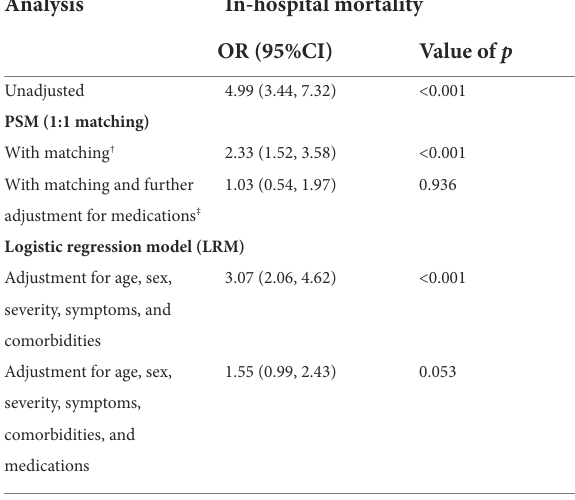
TABLE 1 Demographic and baseline clinical characteristics of 3,111 COVID-19 patients.